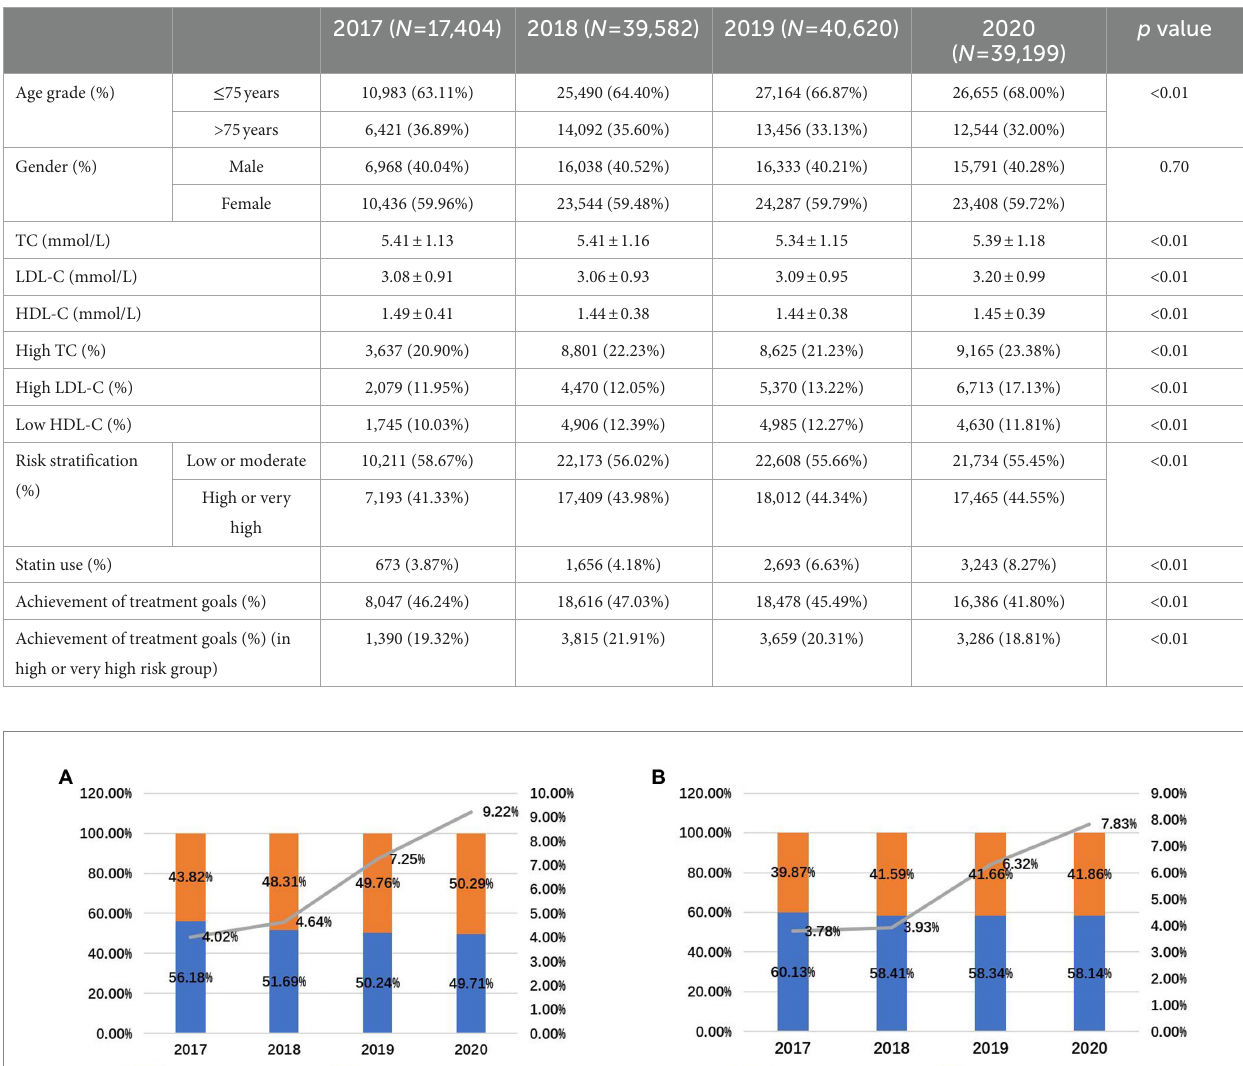
TABLE 2 Cholesterol levels in older adults of each year.